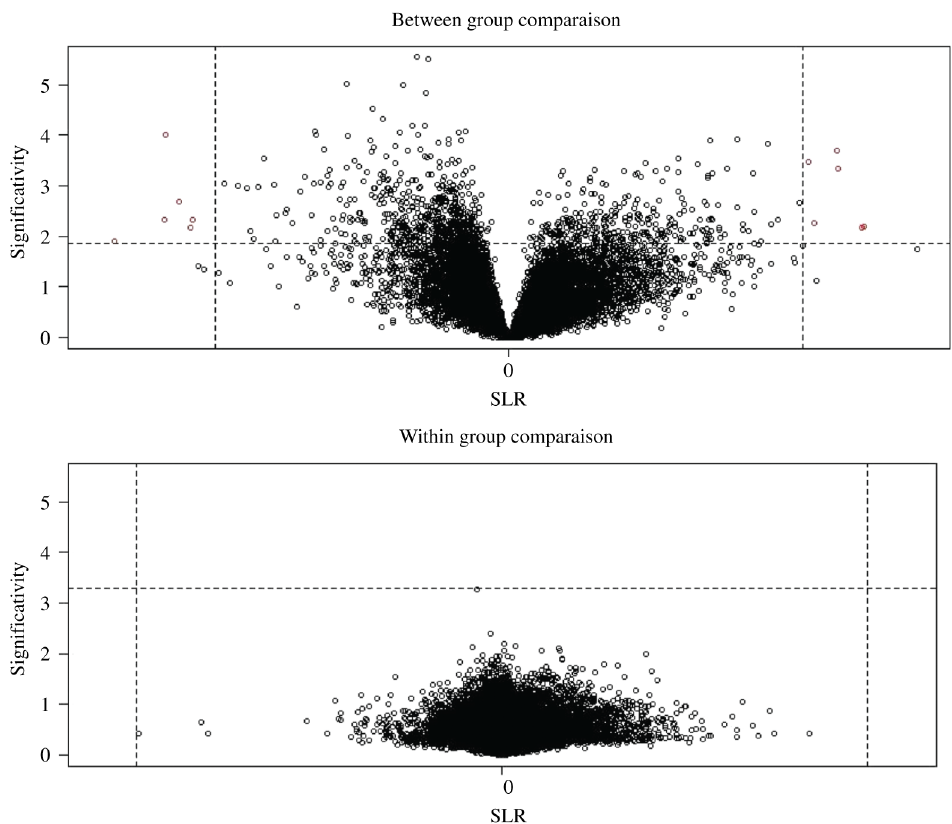
Figure 7: Simple Statistical Test (GSE2443) showing some significant range of the probes (11 probes) in between group comparison and none was found significant in within group comparison.